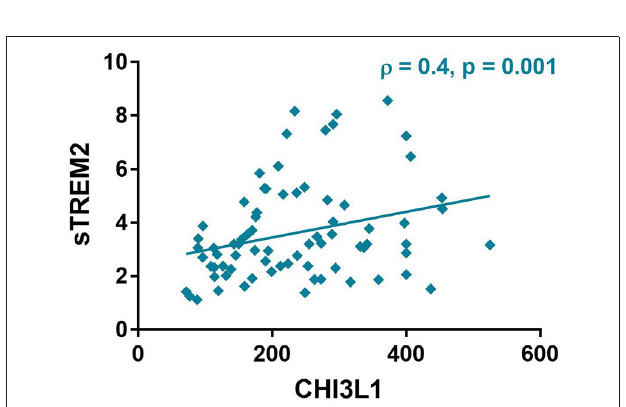
FIGURE 7 | Spearman correlation between chitinase 3 like 1 (CHI3L1) and soluble triggering receptor expressed on myeloid cells 2 (sTREM2), ρ (Spearman